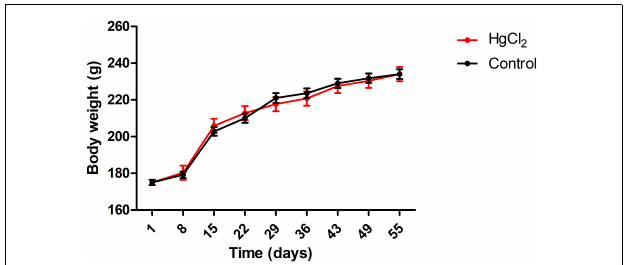
FIGURE 2 | Effects of chronic exposure to HgCl 2 on body weight of adult Wistar rats (g). Results are expressed as mean ± standard error after the one-way ANOVA for repeated measures analysis. Standard error and a one-way ANOVA analysis revealed that there were no significant differences ( p > 0.05) between groups in any time.